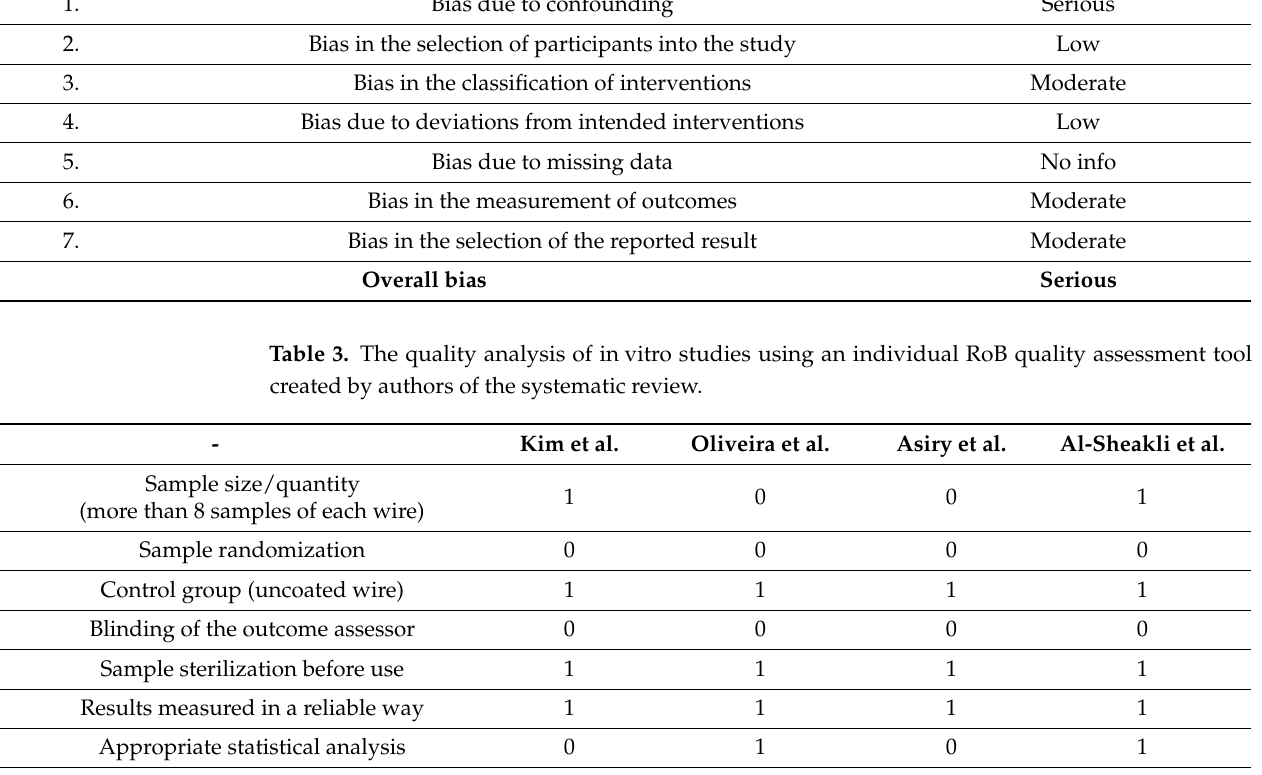
Table 3. The quality analysis of in vitro studies using an individual RoB quality assessment tool created by authors of the systematic review.